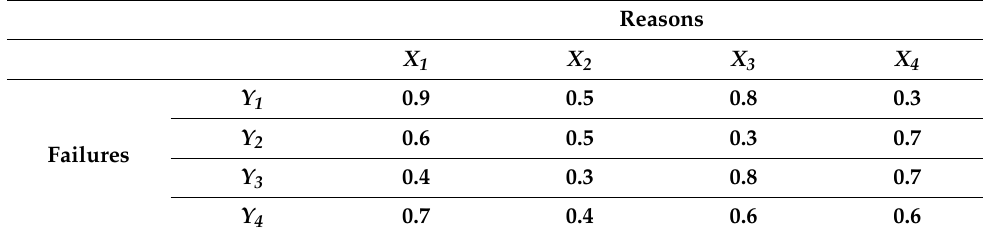
Table 1. Reasons and failures of transformer windings.